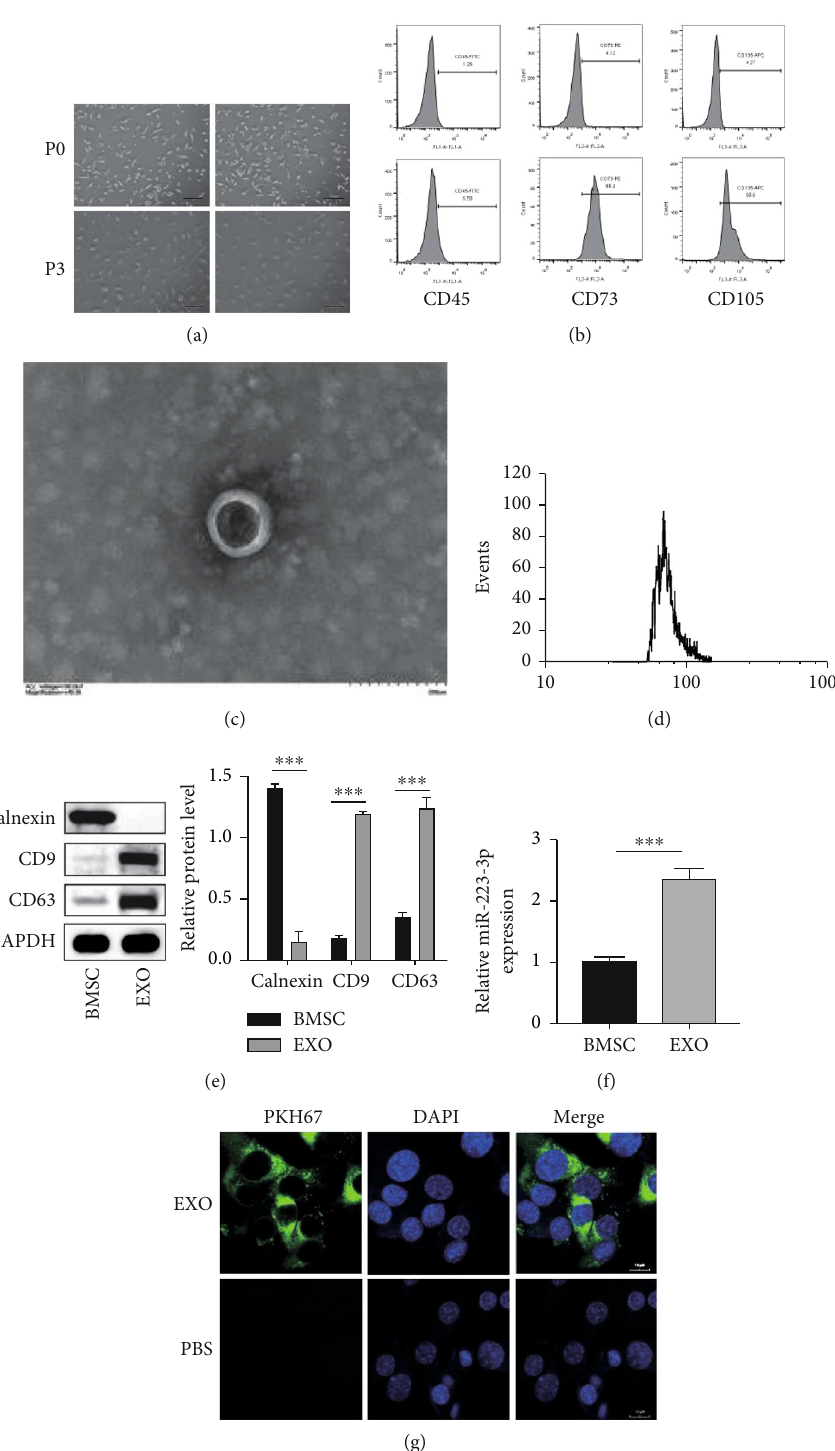
Figure 1: Isolation of BMSCs and BMSC-derived EVs. (a) The morphology of the BMSCs was examined under a light microscope. (b) Flow cytometry was used for identifying the BMSC markers. (c) The morphology of the EVs was observed using TEM. (d) The distribution of the exosome diameters was analyzed. (e) The exosome-speci fi c markers were detected using the western blot analysis. (f) The enrichment of miR-223-3p in the EVs was determined using qPCR. (g) The uptake of PKH67-labelled EVs by the TCMK-1 cells was observed under a fl uorescence microscope. N = 3 . ∗ P < 0 : 05 ; ∗∗ P < 0 : 01 ; ∗∗∗ P < 0 : 001